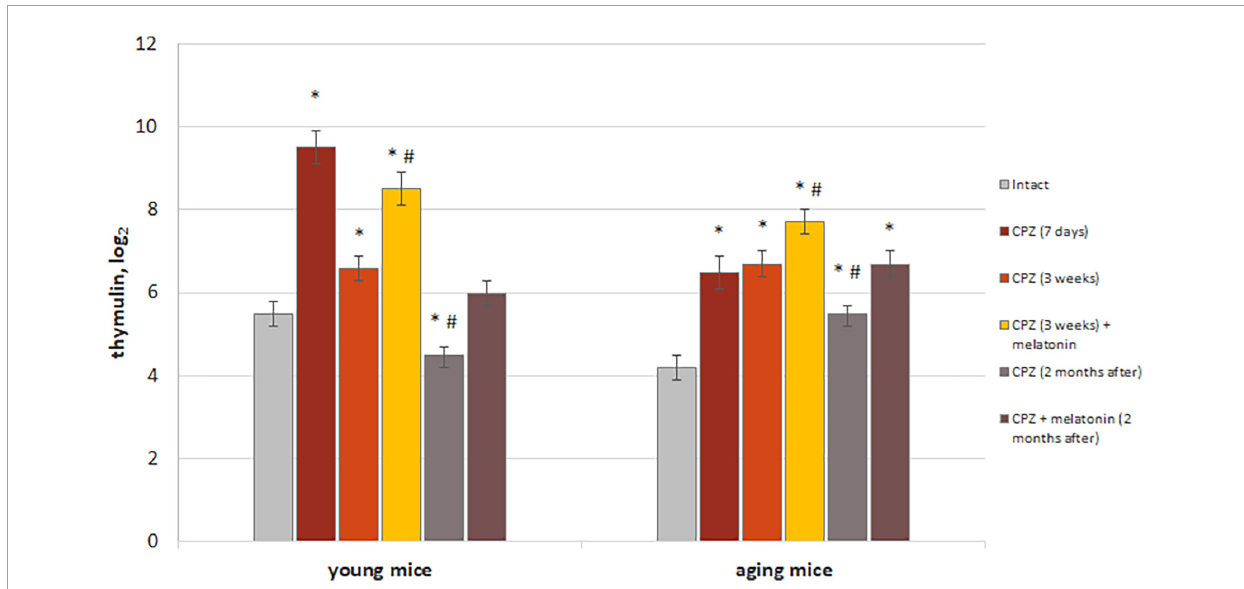
FIGURE10 The effect of cuprizone (CPZ) and CPZ + melatonin on blood thymulin level in young and aging mice of experimental groups ( n = 5 in each group). Represented data are in 7 days, 3 weeks of CPZ diet and 2 months after. Data are M ± SEM. ∗ p < 0.05 compared to intact group; # p < 0.05 compared to 3 weeks of CPZ ( t